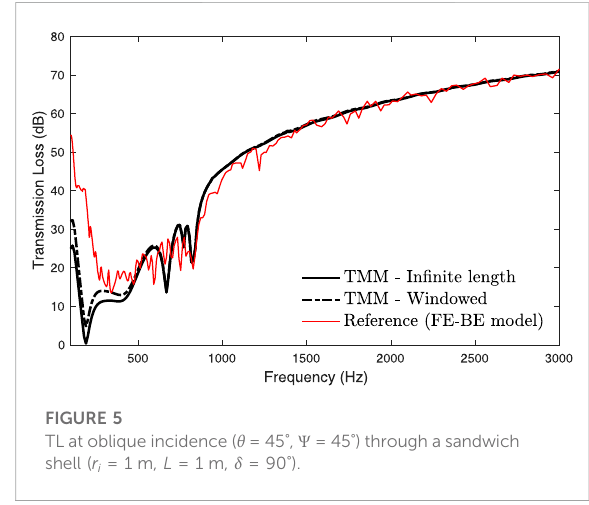
FIGURE 5 TL at oblique incidence ( θ = 45 ° , Ψ = 45 ° ) through a sandwich shell ( r i = 1 m, L = 1 m, δ = 90 ° ).